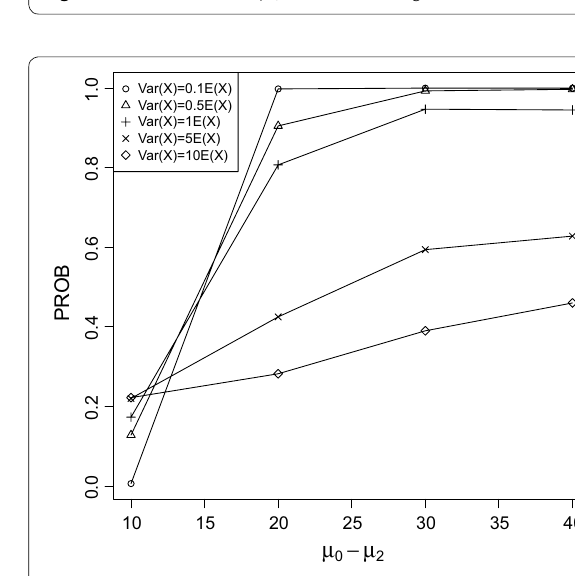
Fig. 4 PROB of the CPCAT; µ 0 = 75 , decreasing trend